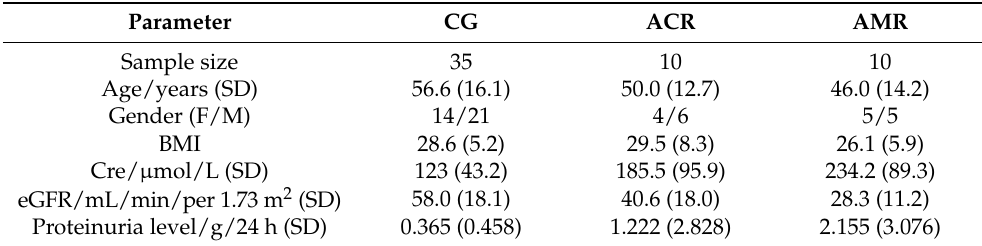
Table 2. Characteristics of patients enrolled in the study by graft rejection, mean values with standard deviation (SD), patients without signs of rejection (CG), with acute cellular rejection (ACR), and with acute antibody-mediated rejection